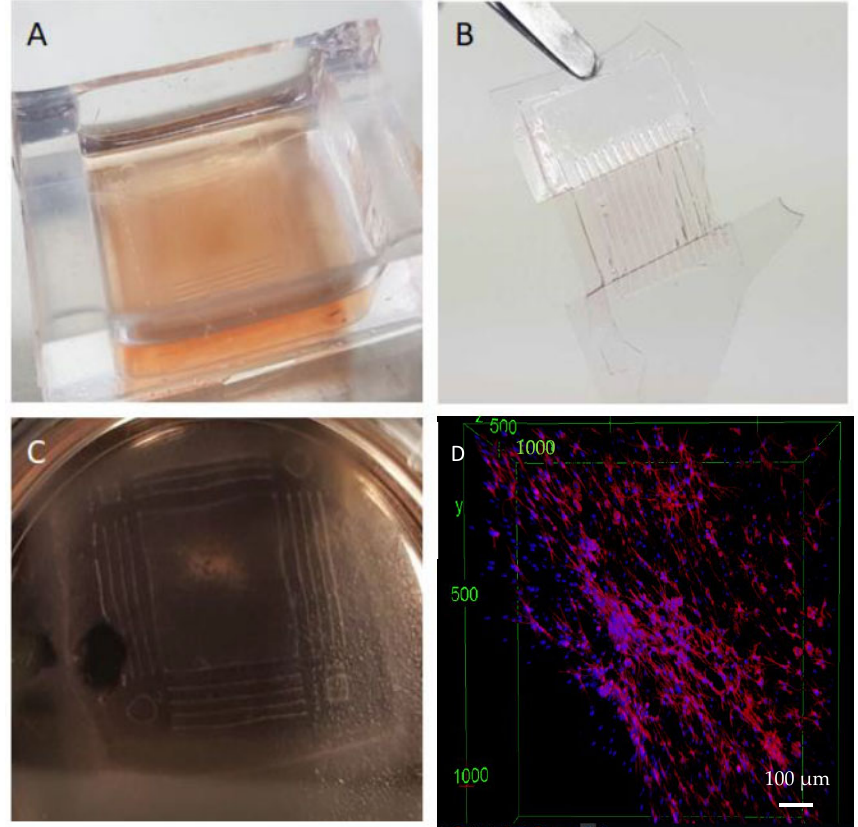
Figure 5. Patterned hydrogel. ( A ) the patterned hydrogel in culture. ( B ) patterned hydrogel once peeled off the PDMS mold. ( C ) Preserved H9c2 cell alignment in the peeled structure. ( D ) the cells are stained with Phalloidin and DAPI to show the alignment stability in the free ‐ standing structure for 7 days after the detachment from the PDMS mold.